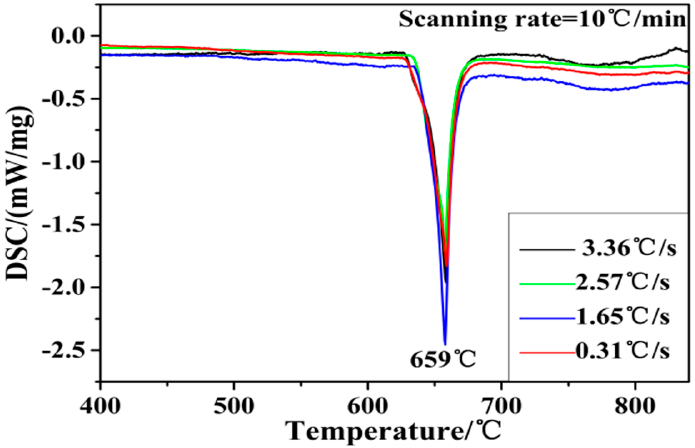
Figure 5. Differential scanning calorimetry (DSC) curve of Al–4Ti master alloy at different cooling rates.